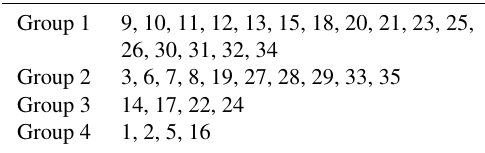
Table 3. Formed groups of ice shelf